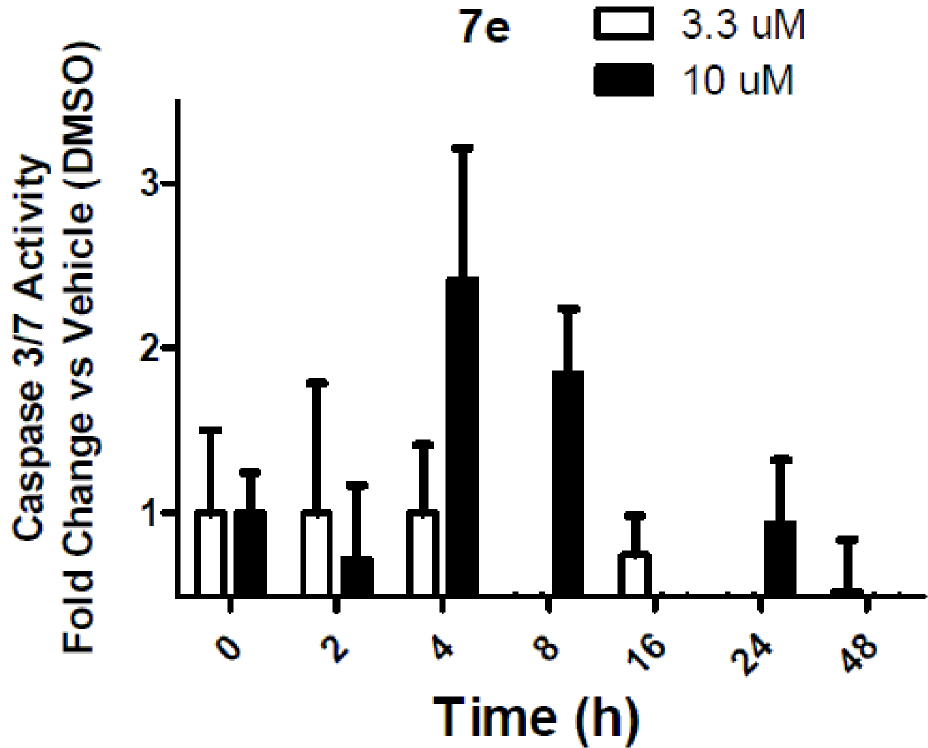
Fig 4. A-549 human lung cancer cells were treated with 3.3 and 10 μ M 7e over a time course from 2–48 h. Caspase3/7 activity was measured by a luminescence-basedhomogenous assay.